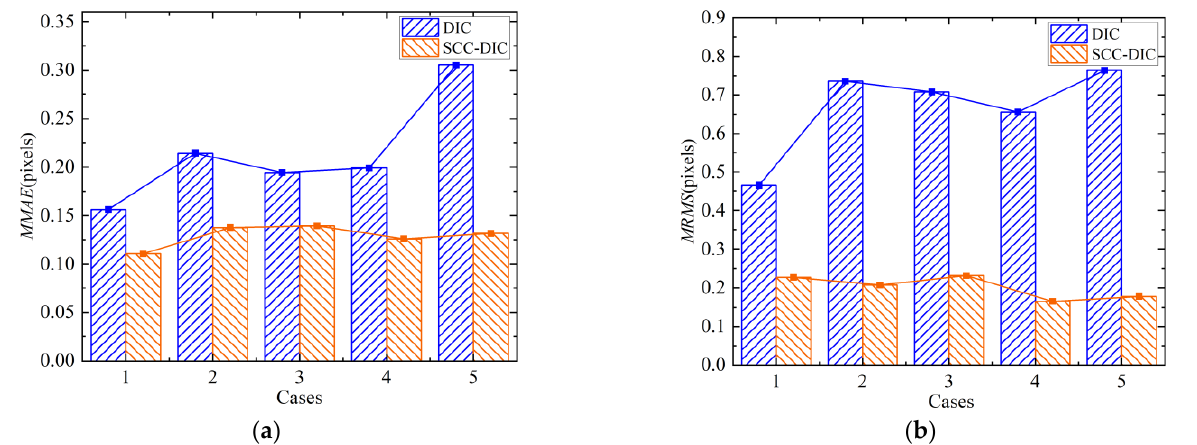
Figure 11. ( a ) MMAE of the two methods; ( b ) MRMS of the two methods.